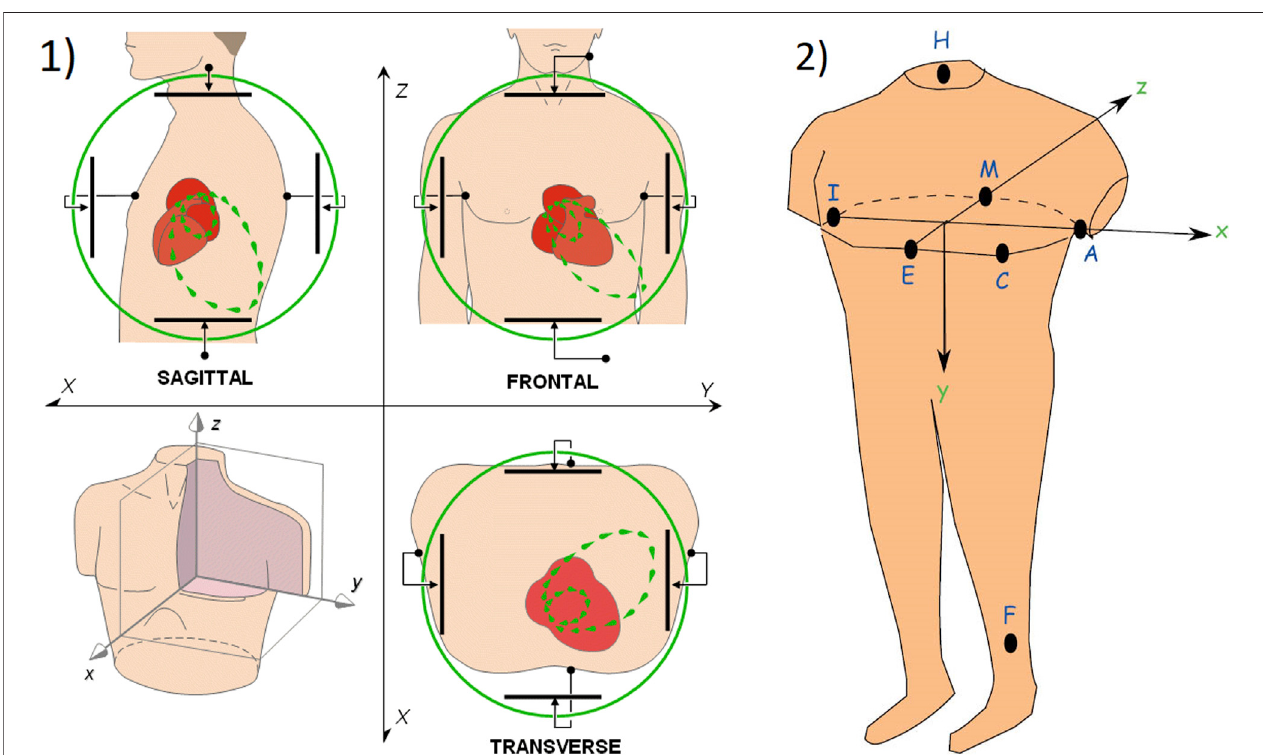
FIGURE 1 | 1) The basic principle of vectorcardiography is illustrated on ideal uniform lead fi elds, which are perpendicular to each other and are in a bipolar con fi guration (set by parallel electrodes on opposite sides of the torso) Malmivuo and Plonsey (1995); 2) Placement of measuring electrodes on the patient body using Frank lead system Hasan and Abbott